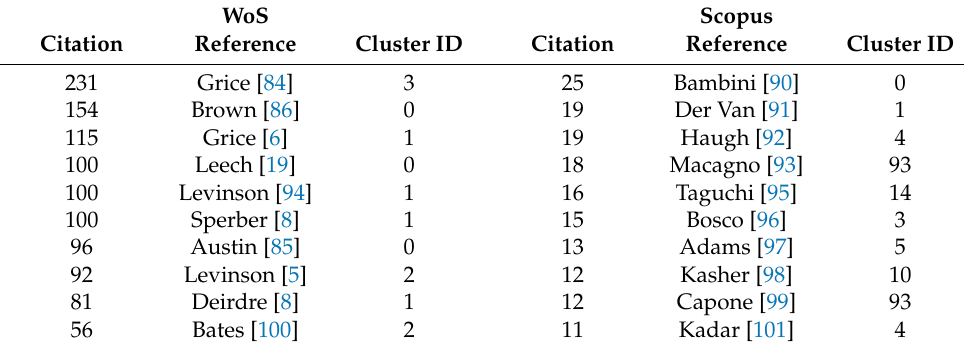
Table 4. Major pragmatics clusters.